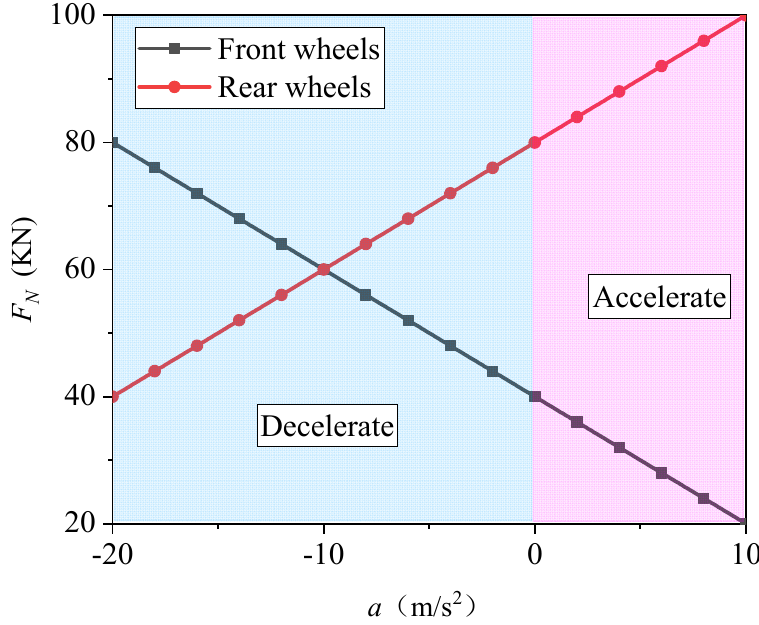
Figure 2. Relationship between ground support forces on front and rear wheels and acceleration.